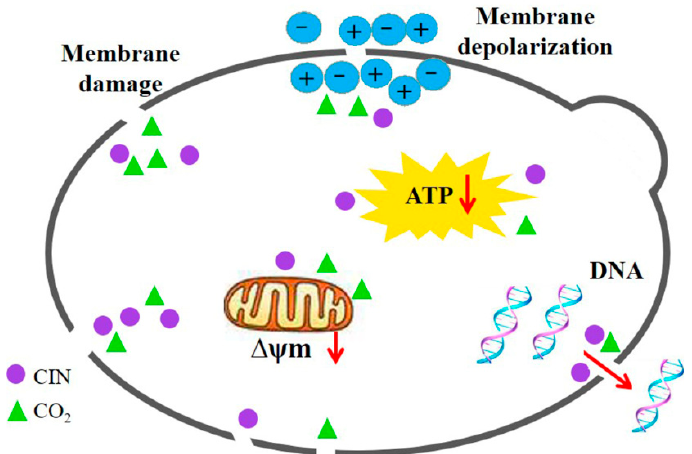
Figure 10. Possible synergistic antifungal mechanism of cinnamon oil (CIN) and petit -high pressure CO 2 against Saccharomyces cerevisiae .